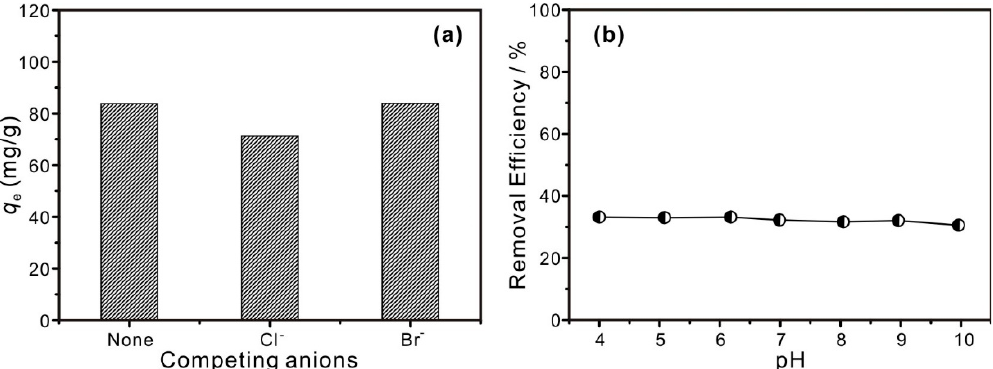
Figure 5. ( a ) I − adsorption capacities of 5-Ag 2 O@MCM-41 under competitive adsorption conditions; ( b ) the effect of initial pH on the I – adsorption on 5-Ag 2 O@MCM-41.